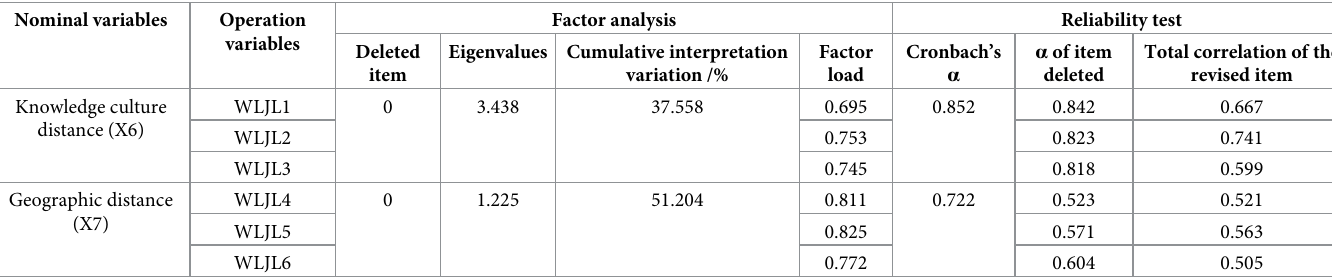
Table 8. Factor analysis and reliability test scale results regarding organizational